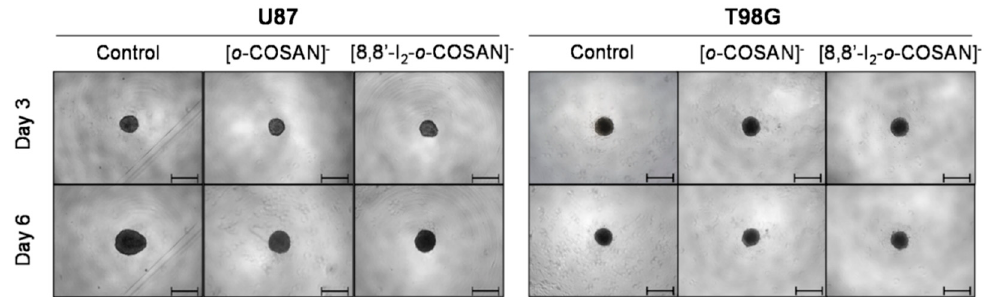
Figure 6. Representative images of the U87 and T98G spheroids before (day 3 of culture) and after 72 h (day 6 of culture) of exposure to the two compounds at their IC50 concentration. Controls consist of spheroids incubated only with medium. Scale bars correspond to 500 µm.